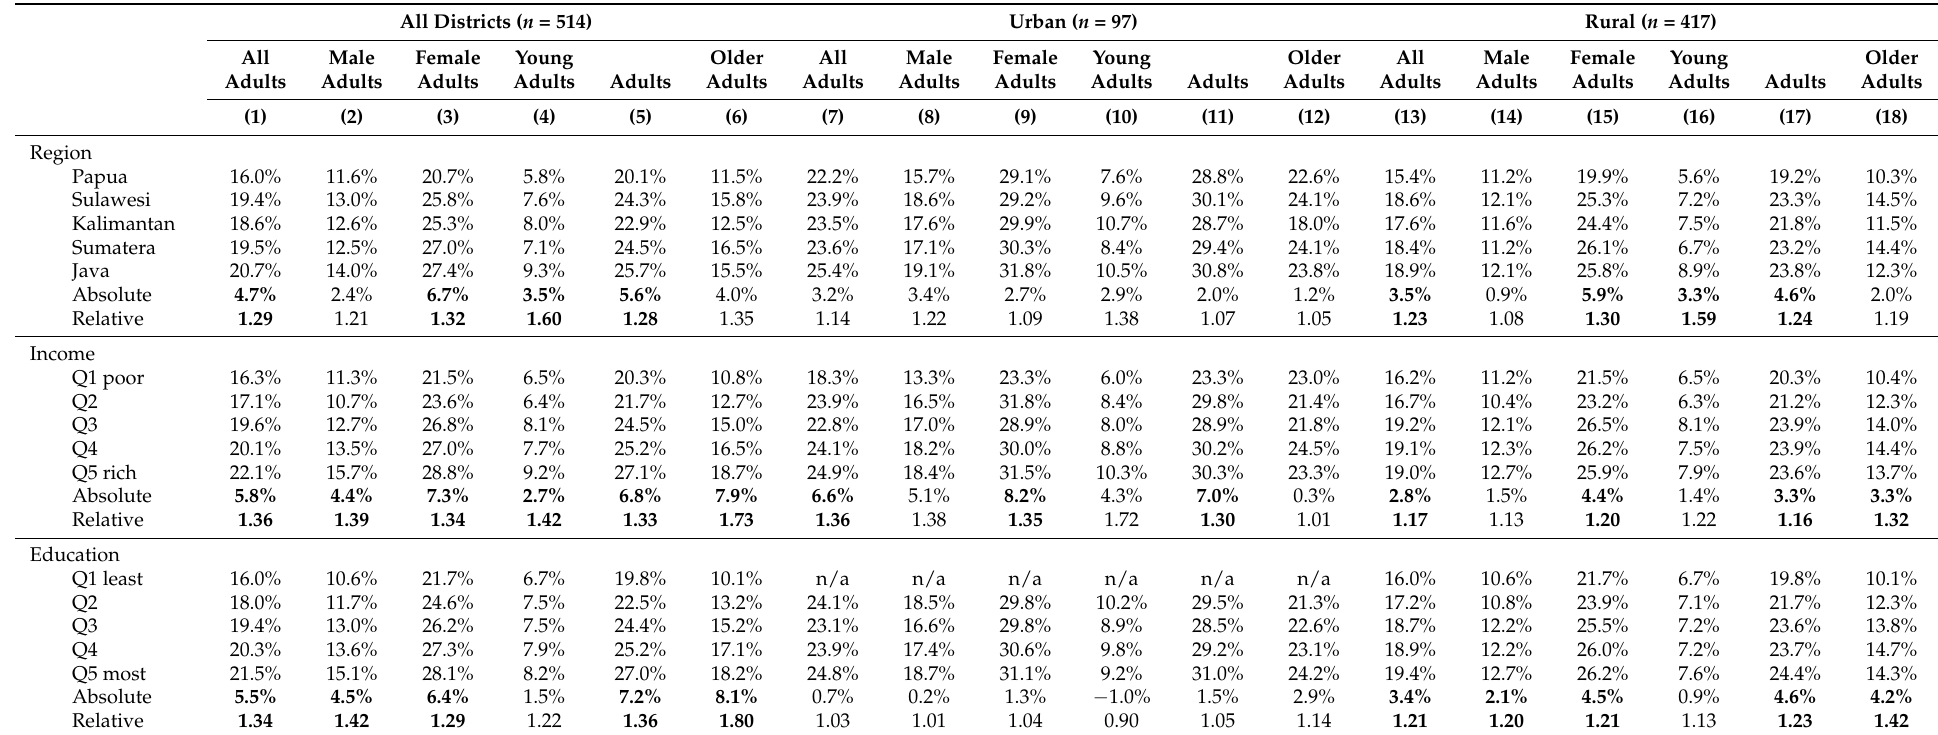
Table 5. Geographic and socioeconomic disparity in obesity among